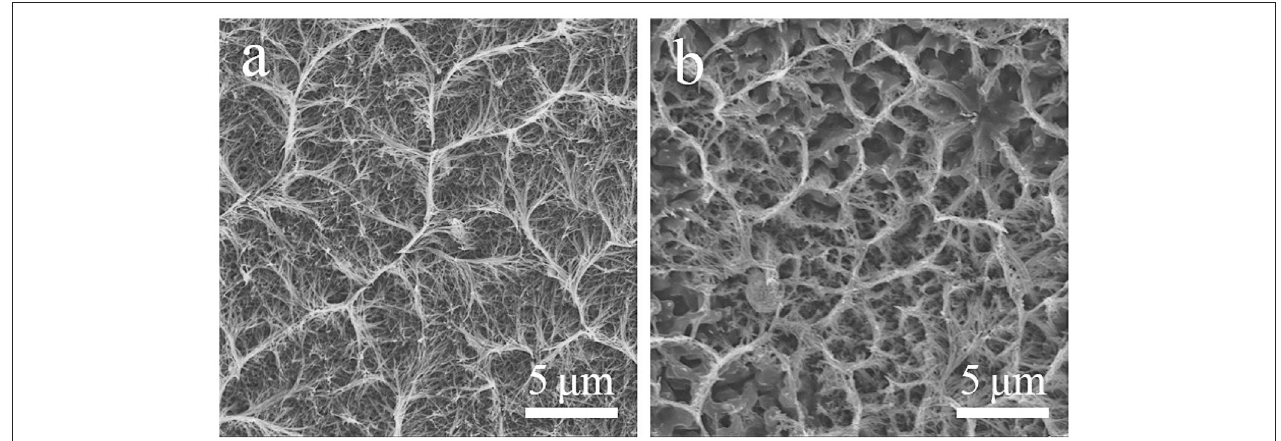
FIGURE 5 | SEM images of Co 3 O 4 NWAs electrode before (a) and after (b) 25,000 cycles.